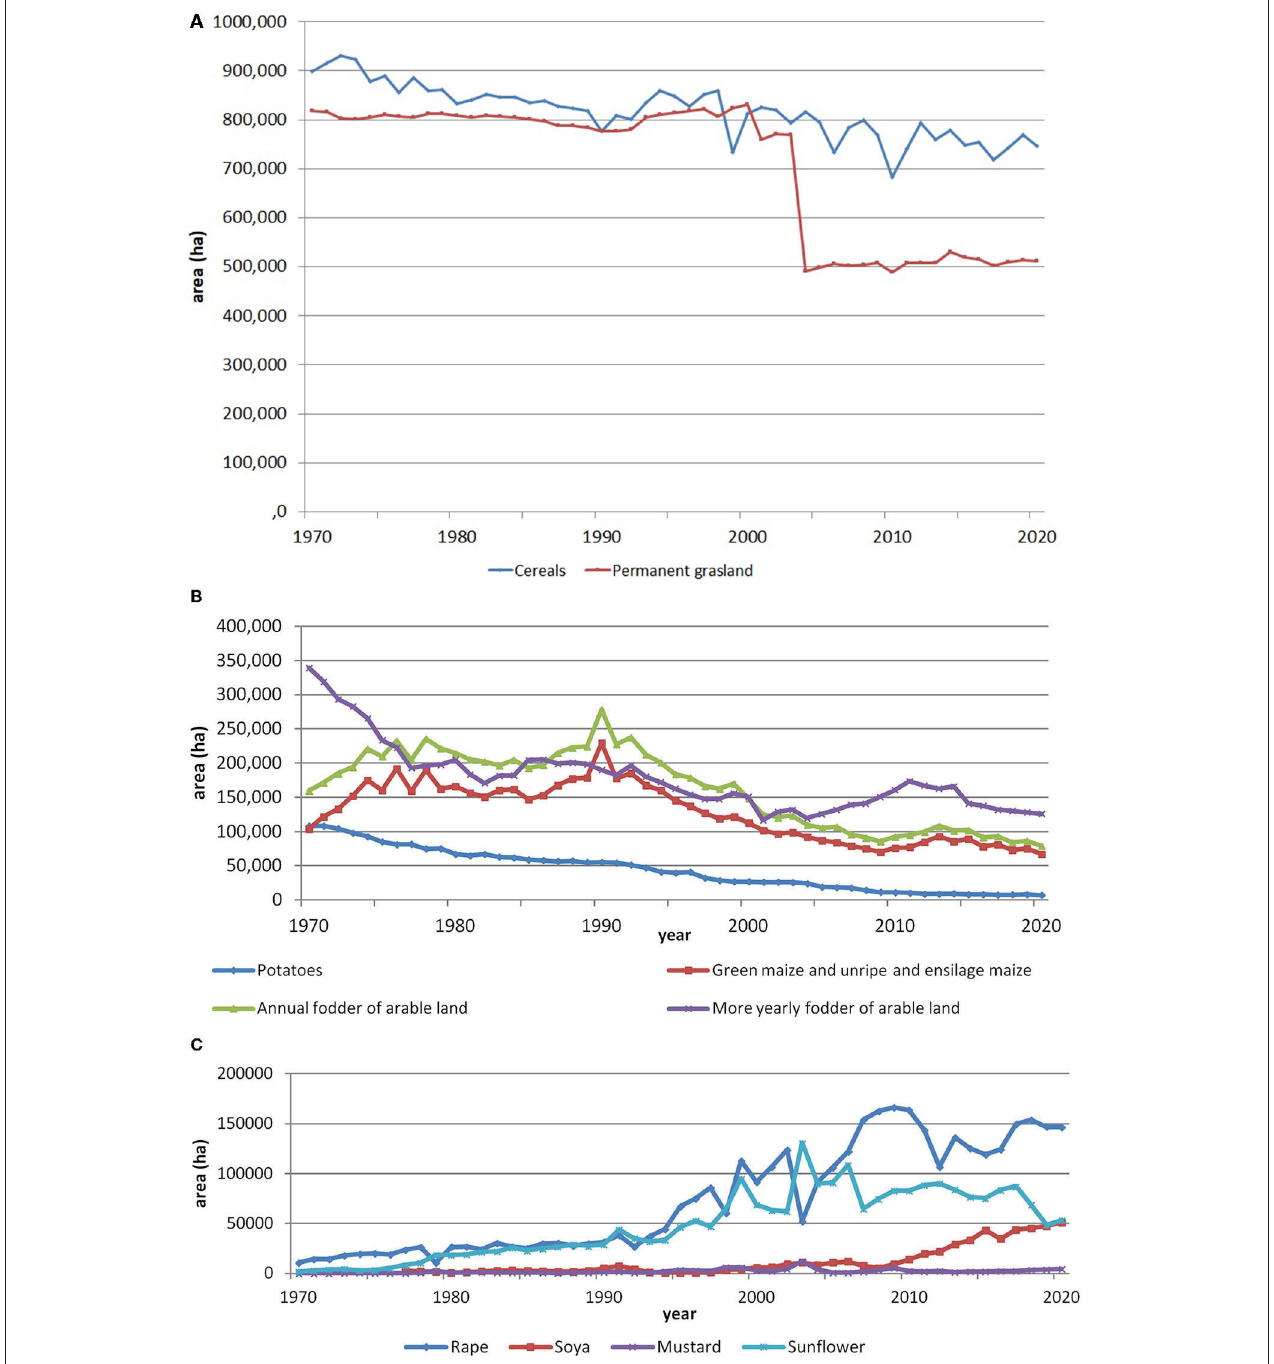
of fodder, sugar beet and potatoes. Uncontrolled cultivation of energy crops can be a threat not only to natural ecosystems but also to individual landscaping components (Fehér et al.,